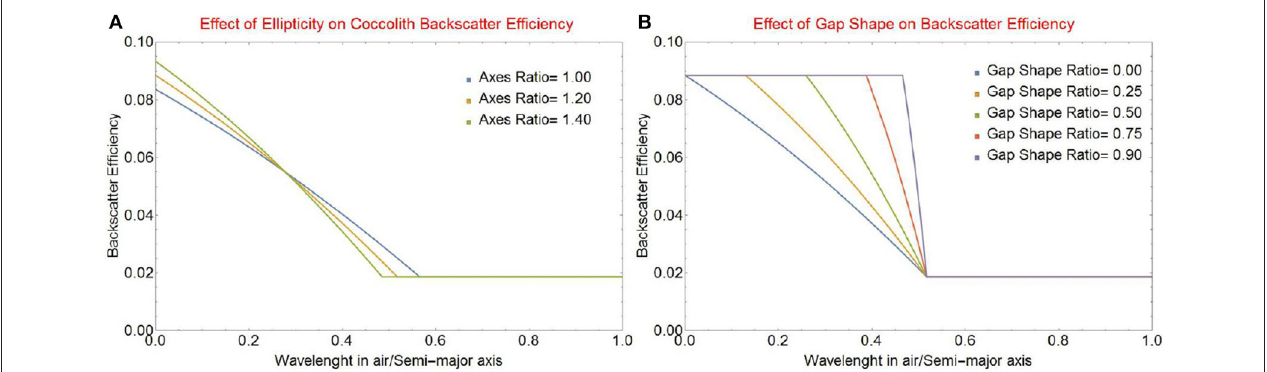
FIGURE 4 | Backscattering efficiency factor Q bbl vs. the ratio of wavelength in air to the length of the semi-major axis of a coccolith a o for (A) various values of the a o / b o of the elliptical coccolith, and (B) various values of the gap shape factor r sh aspect ratio r 0 =